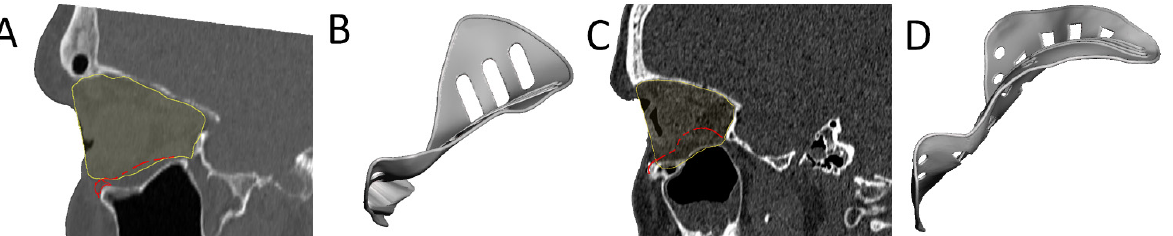
Figure 4. Examples of two patient-specific implant designs with overcorrection (red contour) of the mirrored orbital volume (yellow contour). The first patient-specific implant is designed with an anterior elevation at the infra-orbital rim to compensate for the asymmetry in globe position ( A , B ). The second patient-specific implant is designed with a large overcorrection for an anophthalmic socket reconstruction ( C , D ).